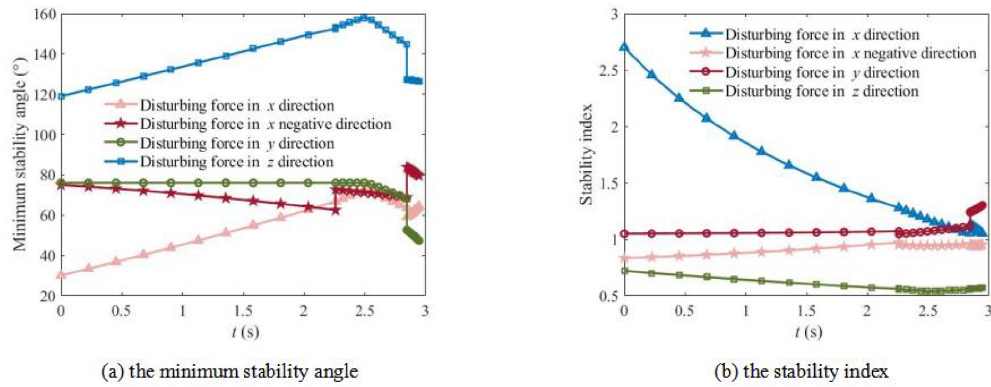
Figure 17. Stability analysis under disturbing force.